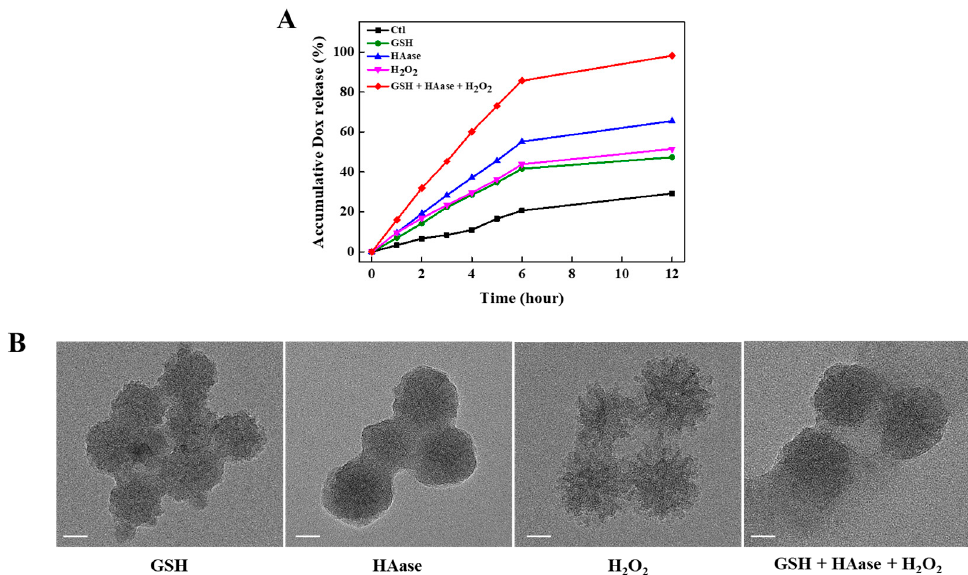
Figure 4. ( A ) Triple-stimuli responsive Dox release profiles from the ID@MOS-Fc-CDHA nanocomposites. ( B ) TEM images of the ID@MOS-Fc-CDHA nanocomposites treated with intracellular GSH, HAase, H 2 O 2, and the GSH-HAase-H 2 O 2 mixture.